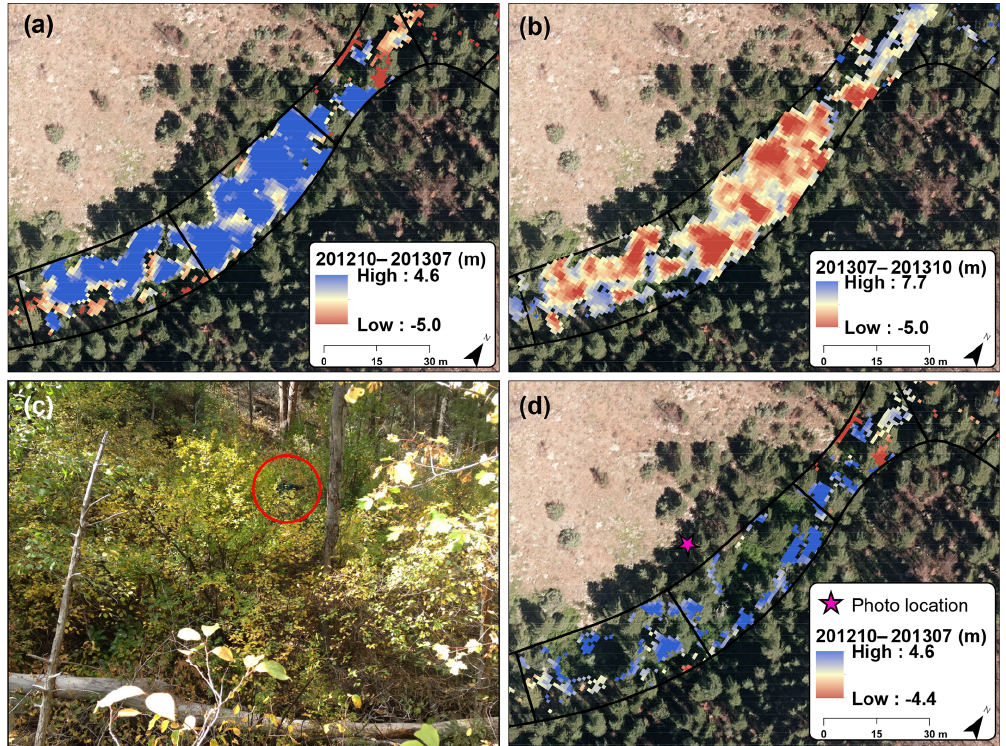
Figure 2. Seasonal changes in vegetation led to spurious deposition during fall to summer DoDs (a) , and spurious erosion in the summer to fall DoDs (b) . The valley bottom in (a) and (b) includes several woody deciduous species along with some ponderosa pine (c) . Panel (d) shows the remaining change after using our raster-based algorithm to reduce the errors due to leaf out and leaf drop. Red circle in (c) identifies the upper half of a person standing in the understory, and the pink star in (d) represents the approximate location of the photo in (c)